Question: What direction does the quantity move in — increasing or decreasing?
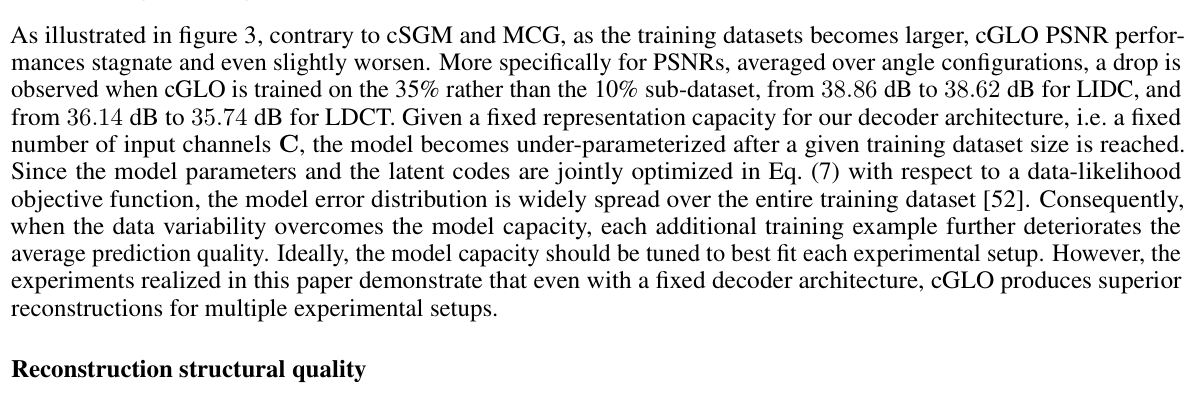
Answer: decreasing